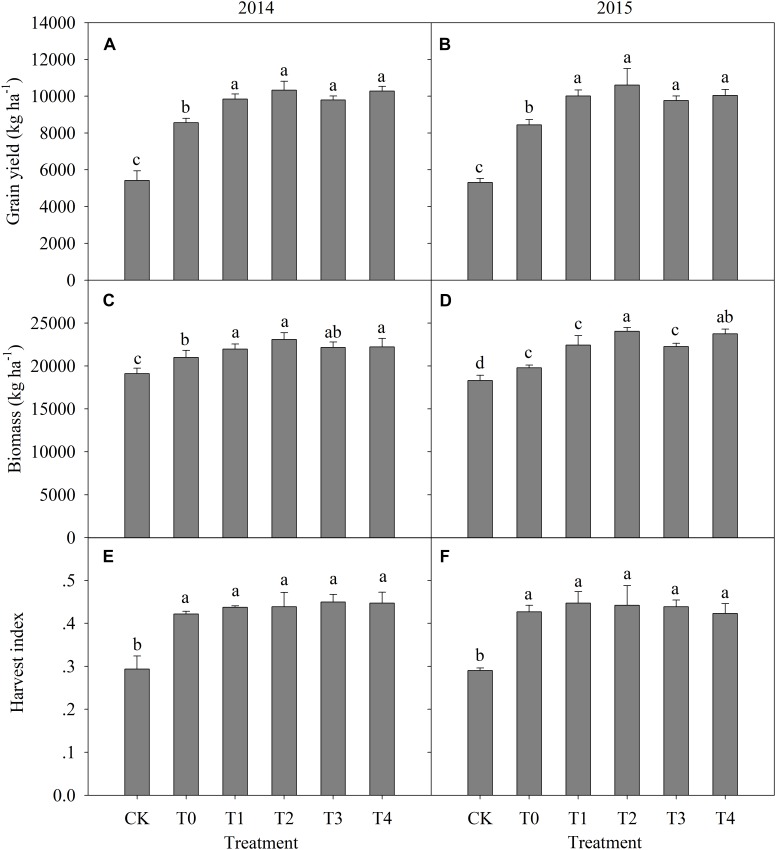
Effects of nitrogen rate, plastic mulching and basal nitrogen application depth on grain yield (A, 2014; B, 2015), biomass (C, 2014; D, 2015), and harvest index (E, 2014; F, 2015) of maize. Different letters in each section of a column indicate significant differences at p < 0.05. CK, no fertilizer and no mulching treatment; T0, traditional broadcast nitrogen fertilizer with mulching treatment; T1, basal nitrogen application at a depth of 6 cm with no mulching treatment; T2, basal nitrogen application at a depth of 6 cm with plastic mulching treatment; T3, basal nitrogen application at a depth of 12 cm with no mulching treatment; T4, basal nitrogen application at a depth of 12 cm with plastic mulching treatment.